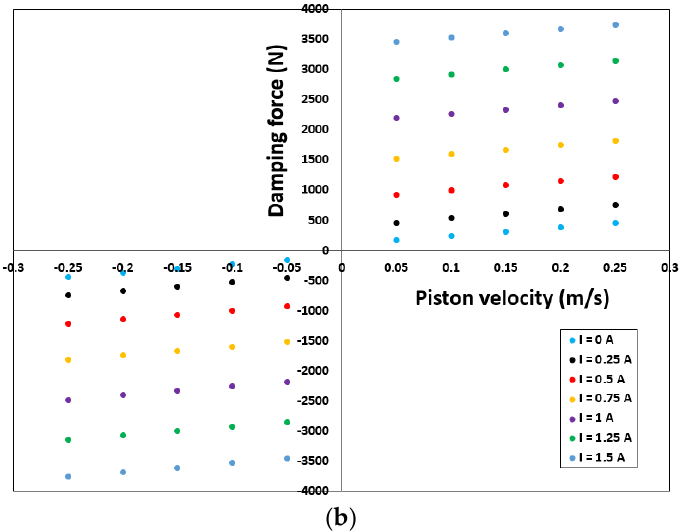
Figure 9. Damping force characteristics: ( a ) damping force versus piston stroke; ( b ) damping force versus piston velocity.